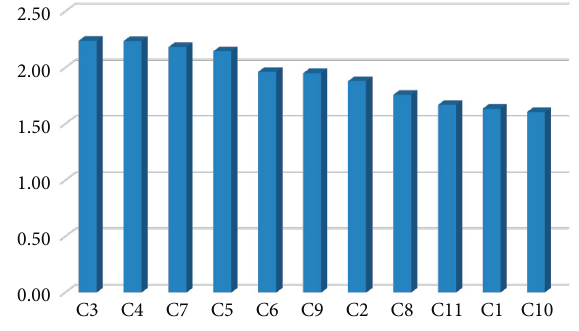
Figure 2: The effectiveness of criteria.